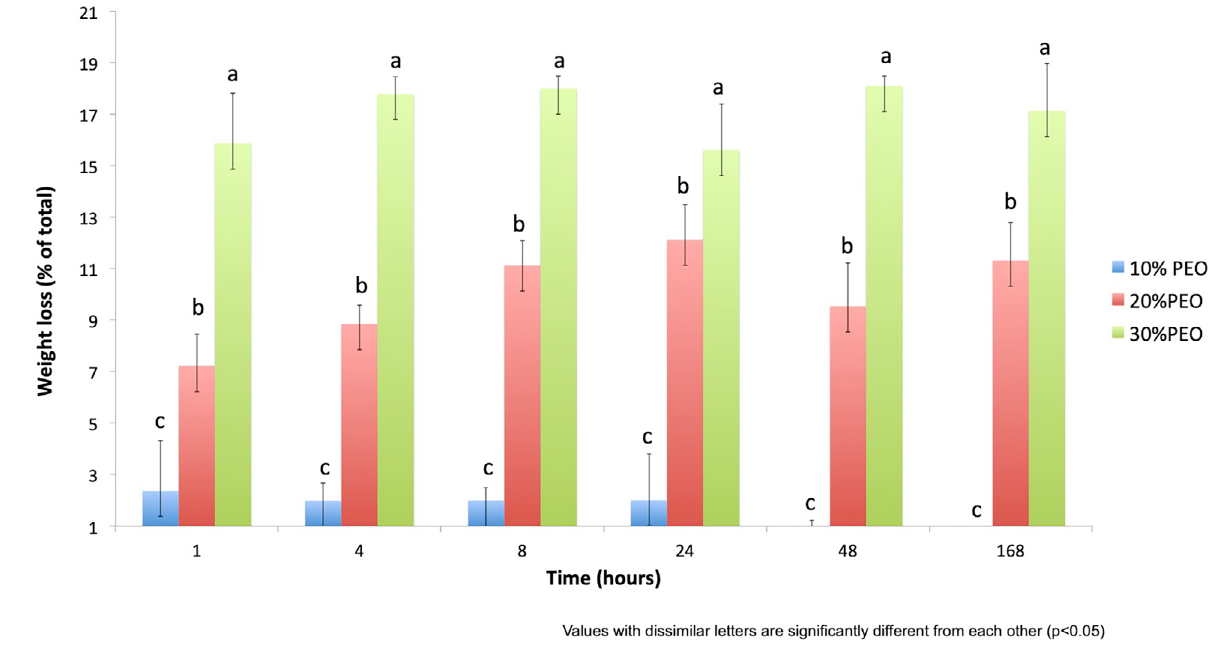
Figure 2- Percentage of weight lost from the PMMA fibers +/- PEO at 10%, 20%, or 30% loading